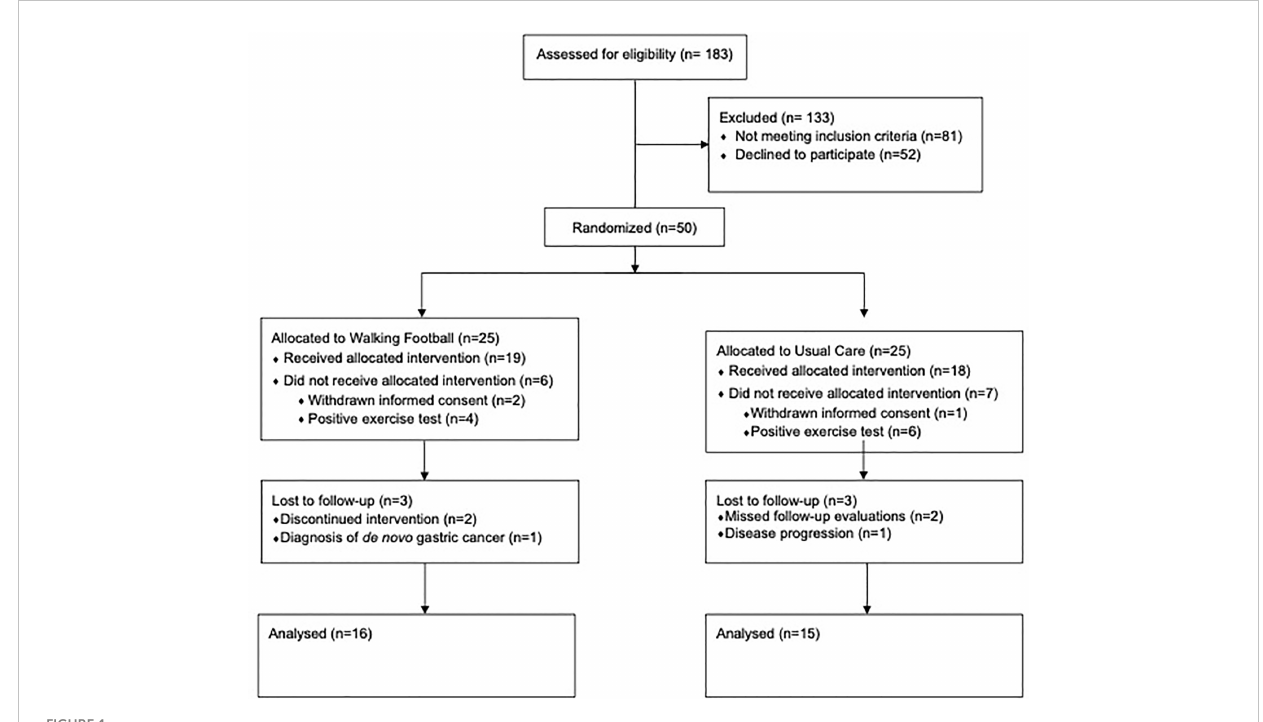
FIGURE 1 Flow diagram depicting the study